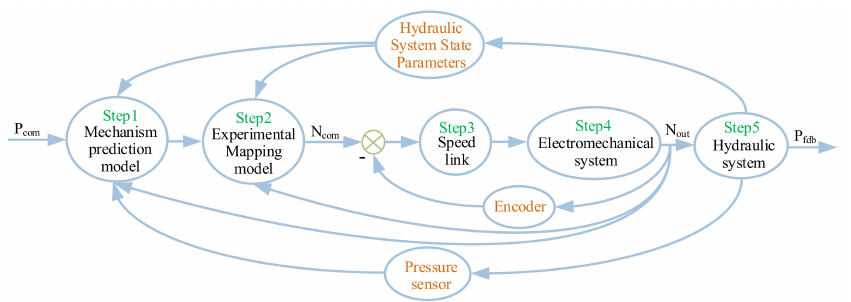
Figure 2. ESPCS pressure control chart.